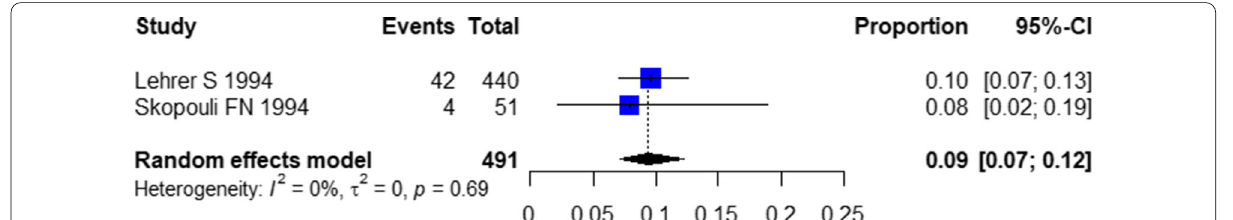
Fig. 5 Meta‑analysis of the prevalence of reproductive dysfunction in women with Sjogren’s